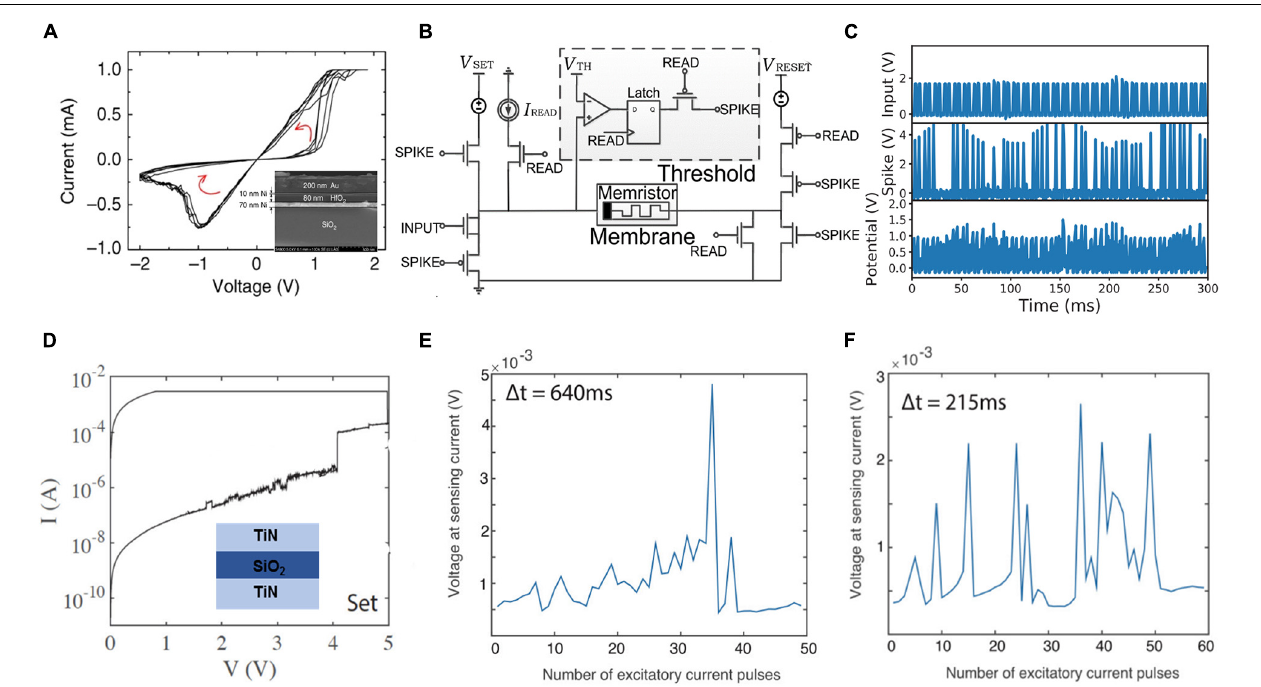
FIGURE 3 | (A) Bipolar resistive switching characteristics of a non-volatile memristor. Inset shows the scanning electron microscope images of a cross-section of the memristor. (B) Circuitry of artificial neuron equipped with complementary metal–oxide–semiconductor (CMOS) circuit. (C) The stochastic output behavior under a certain stimulus. Based on the impulse neuron characteristics of hafnium oxide (HfO 2 ) memristor, the neuron response is obtained for an input of V th = 0.7 V at 100 Hz (Wang J. J. et al., 2018). (D) An abrupt SET process in I/V sweeps of SiO x resistive random-access memory (RRAM) cells during non-volatile memory switching. Device output in the leaky integrate-and-fire neuronal model with the voltage response measured based on an inductive current pulse of 1 mA immediately after excitation of a 4 mA current pulse at an interval of (E) 640 ms and (F) 215 ms (Mehonic and Kenyon,